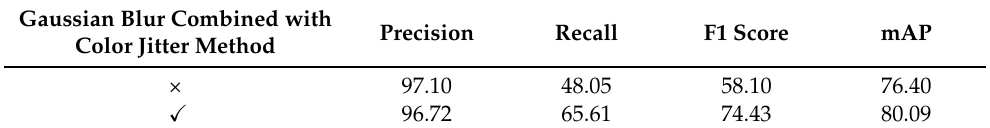
Table 6. Recognition results of a model trained on a vectorized map dataset for our scanned map test set and whether the Gaussian blur combined with color jitter augmentation was used during training. Gaussian Blur Combined with